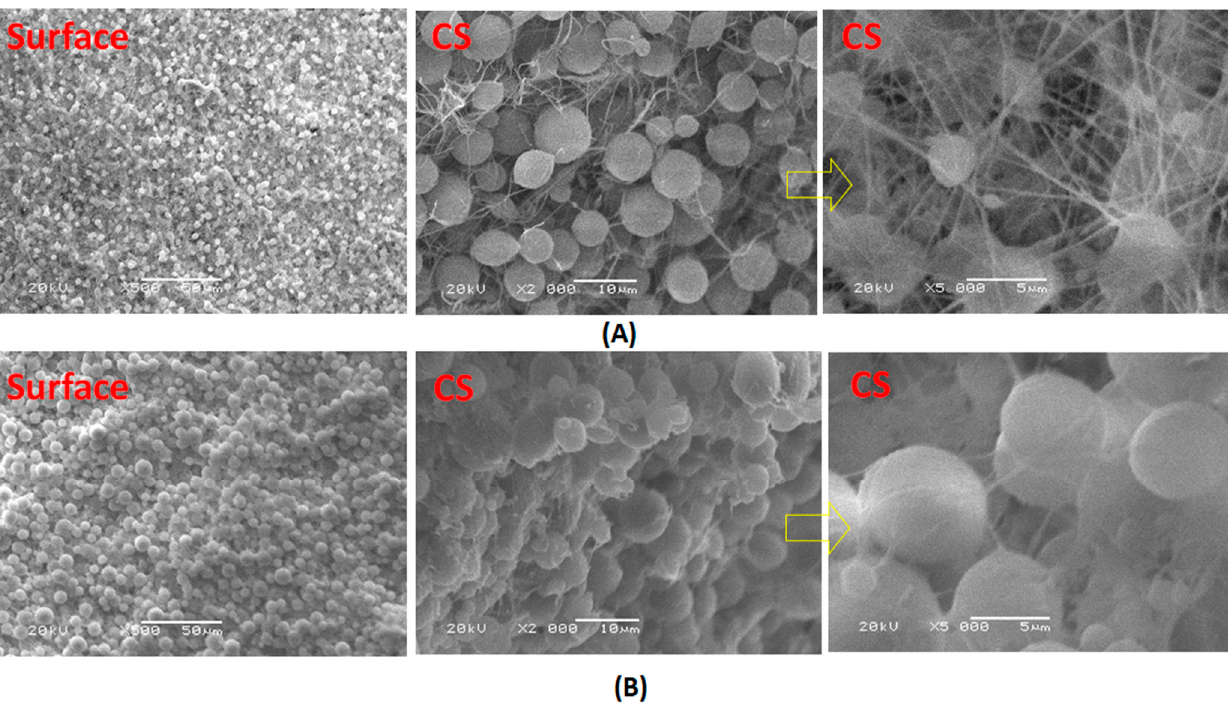
Figure 7. SEM images of PcH/PES blend membranes that were prepared using a 1 NMP: 9 DMF solvents mix and were treated by ( A ) heating at 60 °C and ( B ) phase inversed at 40 °C without LiCl additive. Surface images at ×500 and cross section images at ×2000 and ×5000 were done.